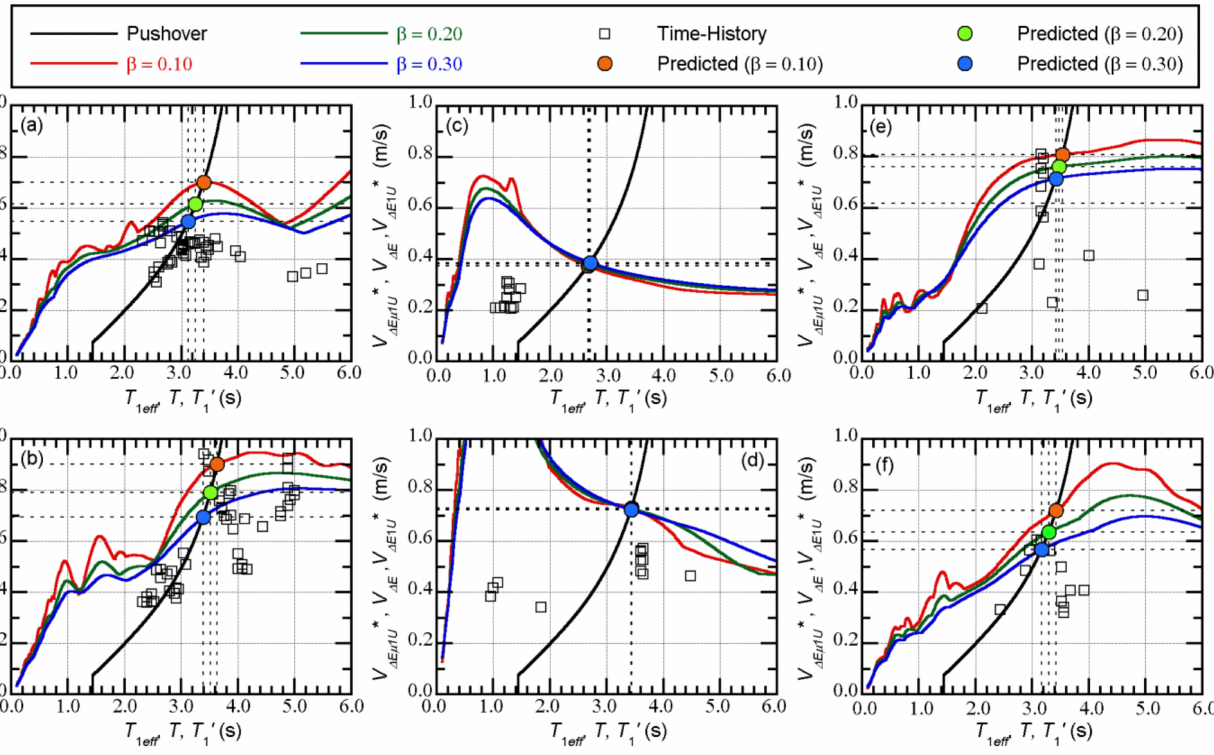
Figure 36. Prediction of V ∆ E 1 U * from the bidirectional V ∆ E spectrum and its accuracy (Model-Tf44): ( a ) Art-1 series; ( b ) Art-2 series; ( c ) UTO0414; ( d ) UTO0416; ( e ) TCU; ( f )